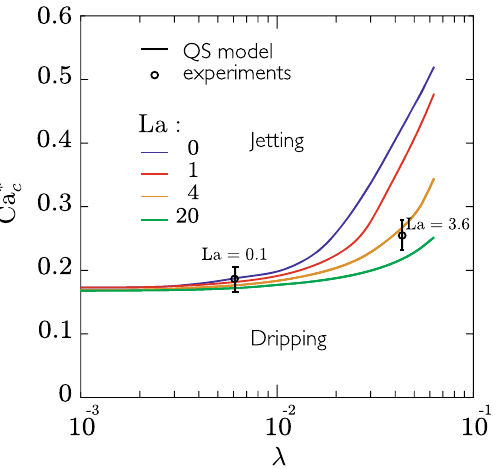
Figure 13. Influence of (cid:31) on the quasi-static dripping-jetting transition at Ca ∗ c for different values of the Laplace number La gauging the role of inertia. The geometry of couple 2 has been